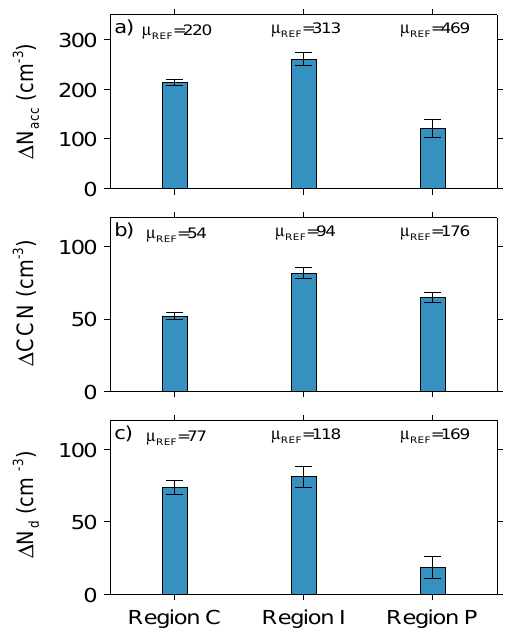
Fig. 3. Mean responses in accumulation mode aerosol ( N a , panel a ) at 975hPa, CCN ( N CCN at 0.1% supersaturation at 975hP, panel b ), and cloud-top cloud droplet number ( N d , panel c ) due to aerosols and gas chemical species from lateral boundaries for regions P, I, and C. The mean response, “ 1 ”, denotes differences in simulated quantities between two simulations with and without aerosols and gas species from the lateral boundaries for a 10-day (15–24 October 2008) simulation period (excluding spin-ups). The mean aerosol or cloud properties in the reference simulation for the corresponding period are shown at the top of each panel for each region (regions P, I, and C) as µ REF